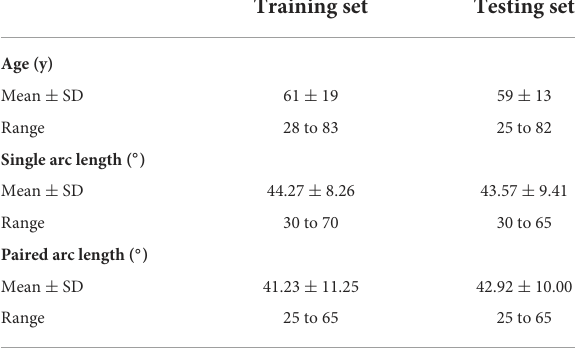
TABLE 1 Patient’s demographics. Training set Testing